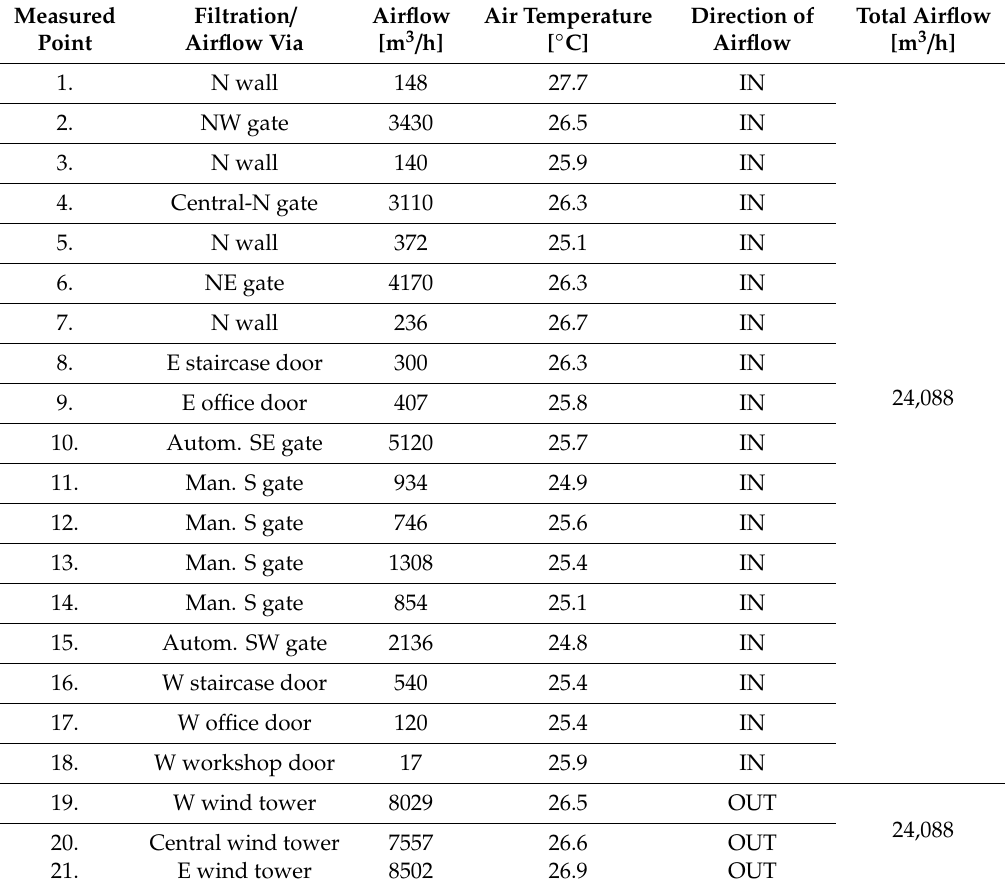
Table 1. Measured infiltration volume flows and temperatures through the envelope openings and perimeter in the production